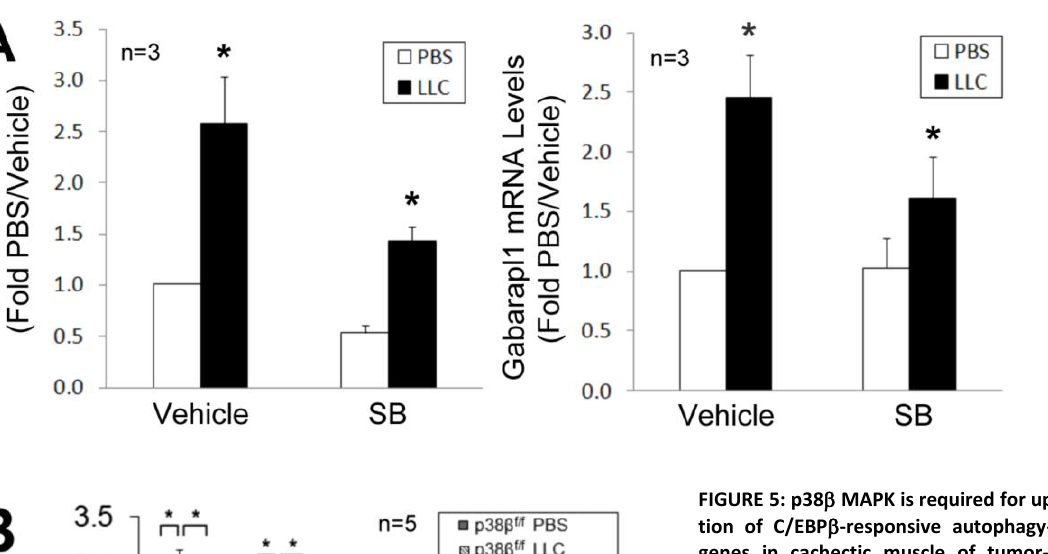
FIGURE 5: p38  MAPK is required for upregula- tion of C/EBP  -responsive autophagy-related genes in cachectic muscle of tumor-bearing mice. (A) Inhibition of p38 MAPK attenuates LC3b and Gabarapl1 upregulation in cachectic muscle of LLC tumor-bearing mice. On day 7 of LLC cells implant to mice, SB202190 was i.p. injected (5 mg/kg) daily with DMSO (50%) as vehicle control. Lysate of TA collected on day 21 was analyzed by qPCR for LC3b and Gabarapl1 mRNA levels. (B) LC3b and Gabarapl1 upregula- tion in the muscle of LLC tumor-bearing mice is dependent on p38  MAPK. Mice with muscle- specific knockout of p38  MAPK (p38  MAPK MKO) or control mice (p38  MAPK f/f ) were im- planted with LLC cells. On day 21, total RNA was extracted from TA of the mice and analyzed by qPCR for LC3b and Gabarapl1 mRNA levels. Data were analyzed by one way ANOVA. * de- notes a difference (p <